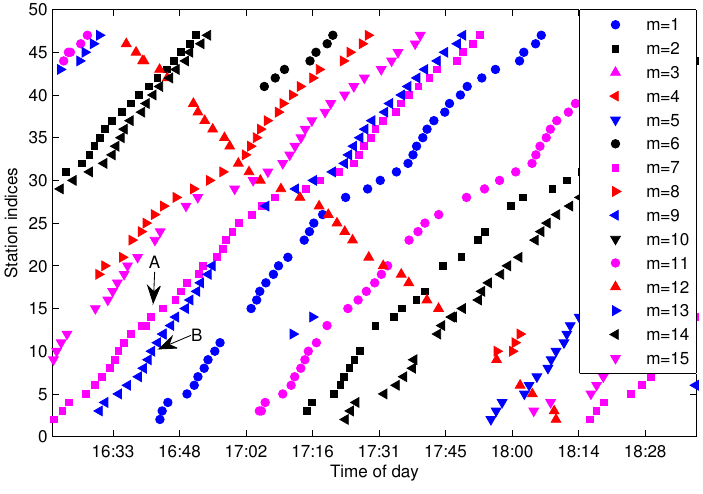
Figure 6. Bus arrival events grouped by G ( m , l ) for the same data G ( l ) as shown in Figure